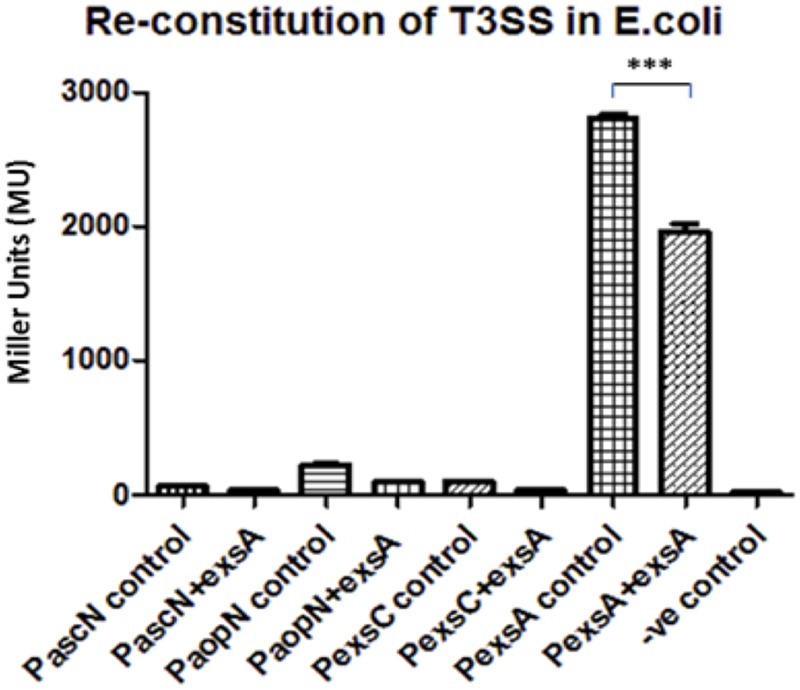
Re-constitution of T3SS regulation in E. coli DH5α. The promoters (P) of the aeromonad T3SS were cloned into reporter plasmid pKAGb-2(-) and fused upstream of a promoter-less lacZ gene. The A. hydrohphila AH3R exsA gene was cloned into pBBR1MCS-5 plasmid and co-transformed into E. coli DH5α with pKAGb-2(-) reporter plasmid constructs. β-galactosidase assays were carried out to measure the promoter activity in the presence or absence of exsA in-trans. Each T3SS promoter activity was measured in the presence of exsA (+exsA) or absence of exsA (control). Negative control (-ve) was measured using promoter-less pKAGb-2(-) plasmid. All of the A. hydrophila T3SS promoters had very low activities in the E. coli re-constitution system except for the promoter PexsA. The promoter activity of PexsA was significantly higher in the absence of exsA rather than in the presence of exsA in-trans (p < 0.001). Assays were carried out in triplicate and the values are the means. The error bars showed Standard Error of the Mean (SEM). The significance was determined using Student’s t-test (∗∗∗p < 0.001).